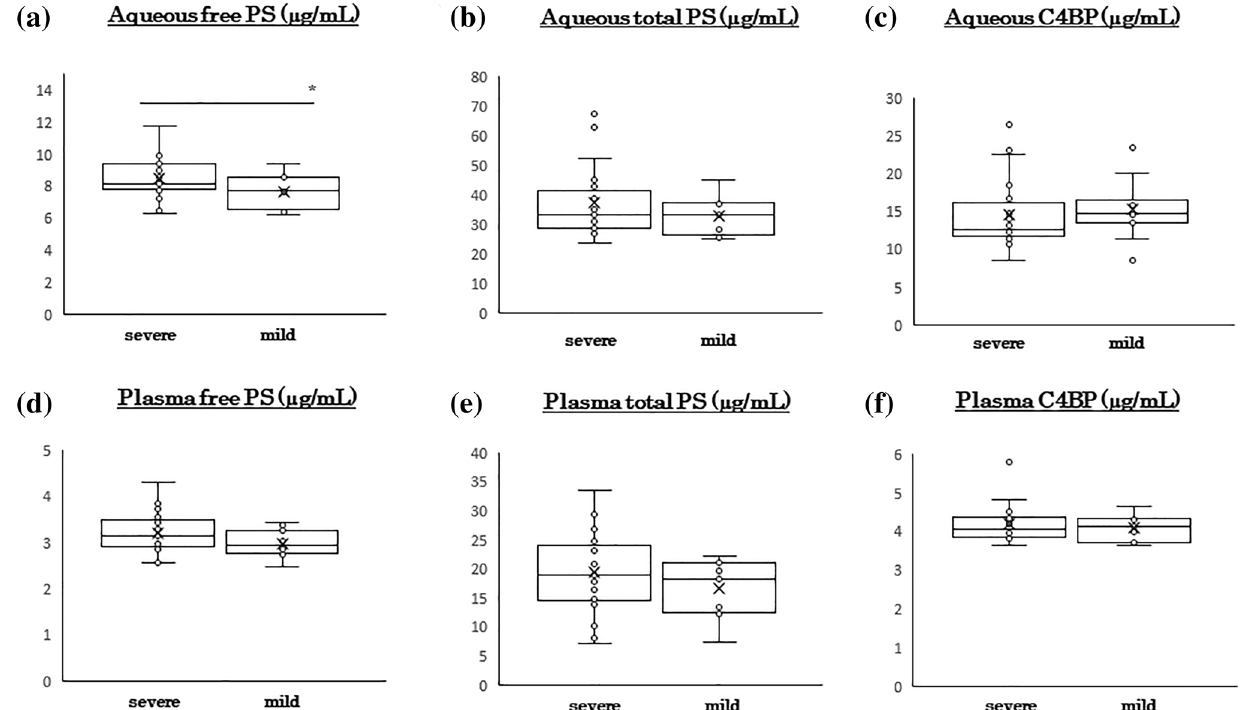
Figure 3. Degree of DME affects ocular protein S concentration. The DME eyes were divided into two groups; severe DME group (CMT ≥ 350 μm, n = 25) and mild DME group (CMT < 350 μm, n = 12). The aqueous humor free PS level is significantly higher in the severe DME group than in the mild DME group ( a ). The aqueous humor levels of total PS ( b ) and C4BP ( c ) are not significantly different between the groups. The plasma levels of free PS ( d ), total PS ( e ), and C4BP ( f ) were not significantly different between the groups. C4BP, C4b-binding protein; CMT, central subfoveal macular thickness; DM, diabetes mellitus; DME, diabetic macular edema; PS, protein S. * P < 0.05. Statistical analysis by Mann–Whitney U